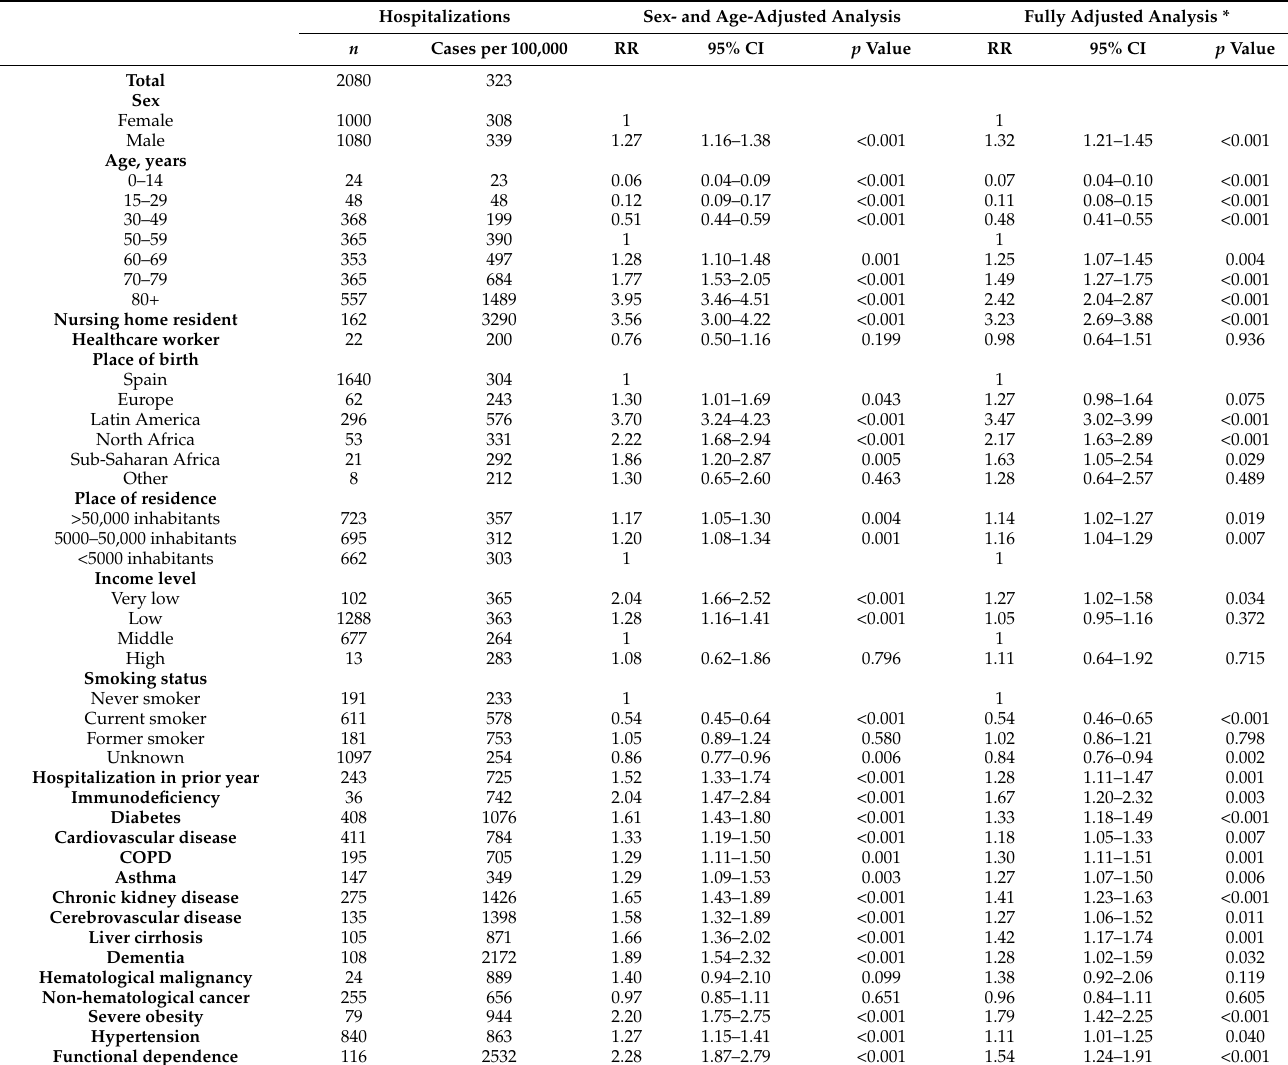
Table 2. Association between potential predictive factors and COVID-19 hospitalization in the general population